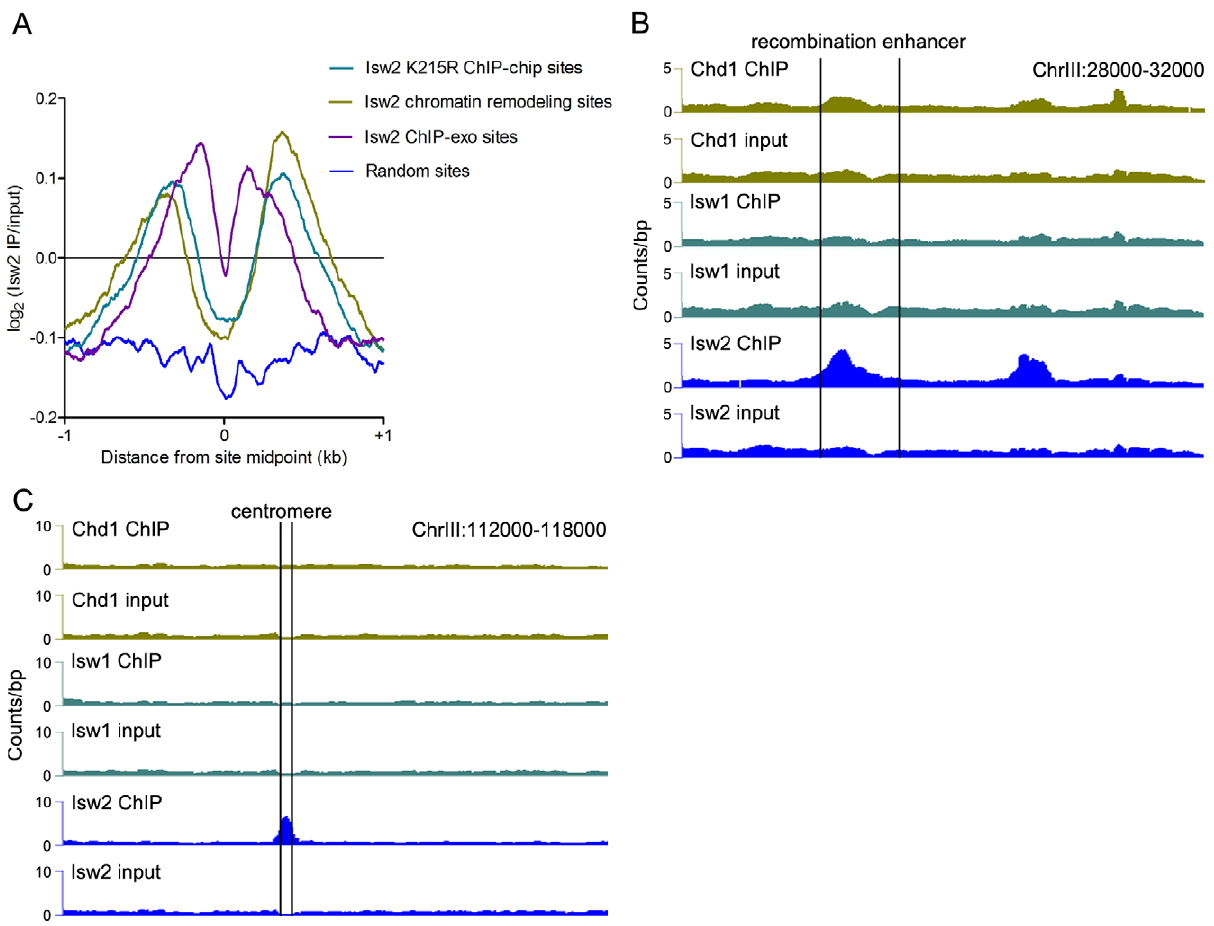
Figure 2. Comparison of Isw2 N-ChIP and X-ChIP data. (A) Aggregate profiles of log 2 (Isw2 IP/input) at sites bound by catalytically inactive (K227R) Isw2 in ChIP-chip experiments (2128 sites), sites with altered nucleosome positioning in an isw2 D strain (1399 sites), sites bound by wild-type Isw2 in ChIP-exo experiments (1251 sites), and around random nucleosomes (1399 sites).Also shown are profiles of remodeler binding at the (B) chrIII recombination enhancer and (C) chrIII centromere (marked by vertical